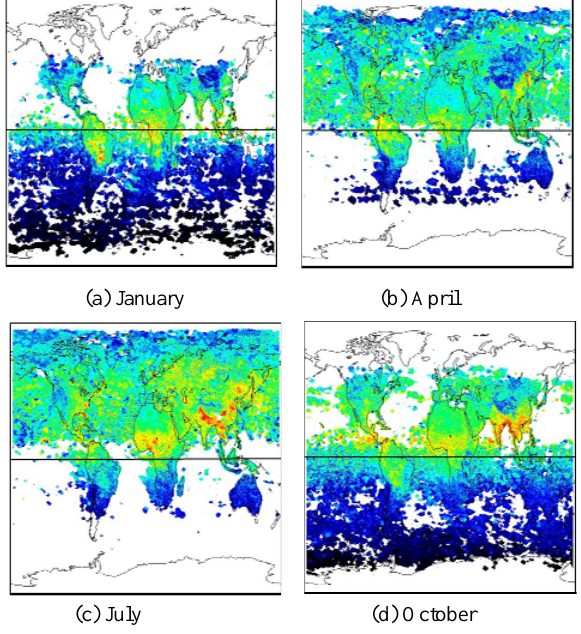
Figure 4. Time-series changes in methane